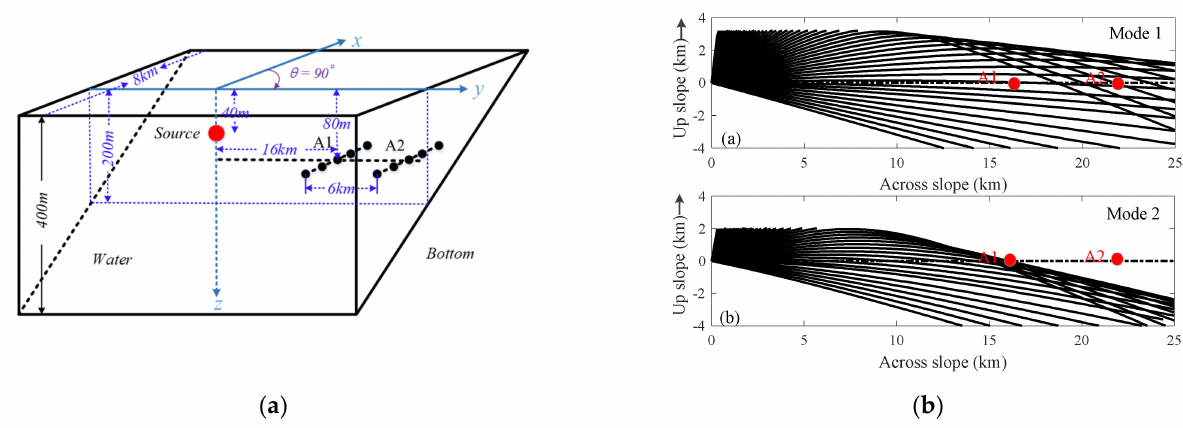
Figure 1. ( a ) Geometry of the 3D wedge-shaped waveguide; ( b ) the corresponding modal ray diagrams for Modes 1 and 2. The right panel of Figure 1 shows the modal ray diagrams in the horizontal xoy